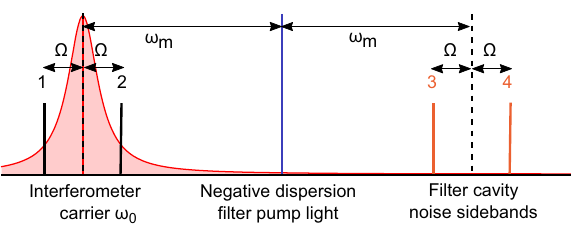
Fig. 4 Coupled optomechanical cavity containing a bulk acoustic wave (BAW) resonator. The following cavity parameters are used in the Fig. 6 Optical frequencies present in the negative dispersion fi lter. The calculation of optomechanical coupling to BAW resonator antiphase surface gravitational wave (GW) signal sidebands, labelled “ 1 ” and “ 2 ” , are detuned motion. The BAW resonator position is denoted using x 1 at the fl at face and from the interferometer carrier frequency ω 0 by the GW signal frequency Ω . x fi eld amplitude in the vacuum The resonance peak of the interferometer and fi lter cavity is shown centered 2 at the apex of the curved face. The electric spaces is denoted by E 1 and E 4 . The electric fi eld inside the crystal is around ω 0 . The fi lter cavity is pumped by light that is blue detuned from the composed of a superposition of E 2 and E 3 .The cavity length is denoted as L f . carrier by the mechanical frequency ω m . Additional noise sidebands “ 3 ” and “ 4 ” are present at ω + 2 ω Ω , which couple to the GW signal sidebands 0 m ± “ 1 ” and “ 2 ” , introducing extra quantum noise at ω Ω 0 ±